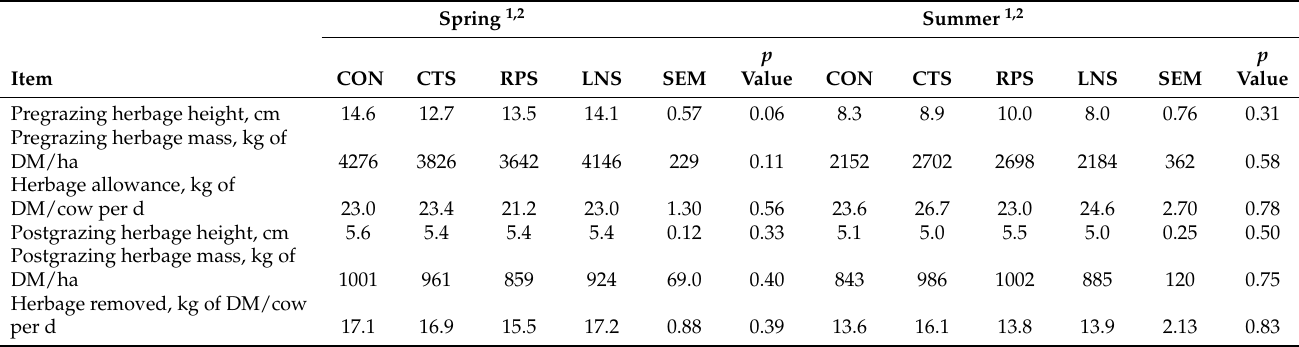
Table 2. Effect of oilseed supplementation on pasture characteristics in the spring and summer seasons. Spring